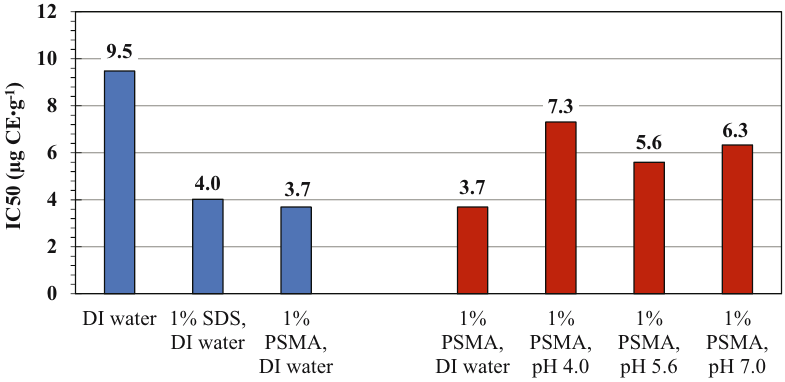
Figure 5: Comparison of the DPPH scavenging assay IC 50 values in the co ff ee leave extracts by di ff erent extracting